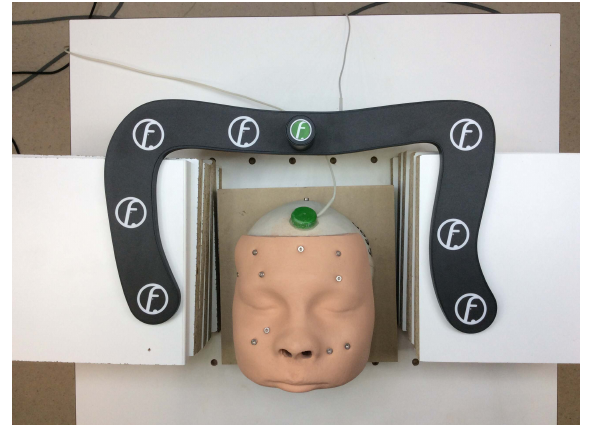
Figure 1: Marker arrangement on frame largely circumferencing the patient’s face to limit extrapolation. Phantom and image were used for the accuracy investigation described in Section